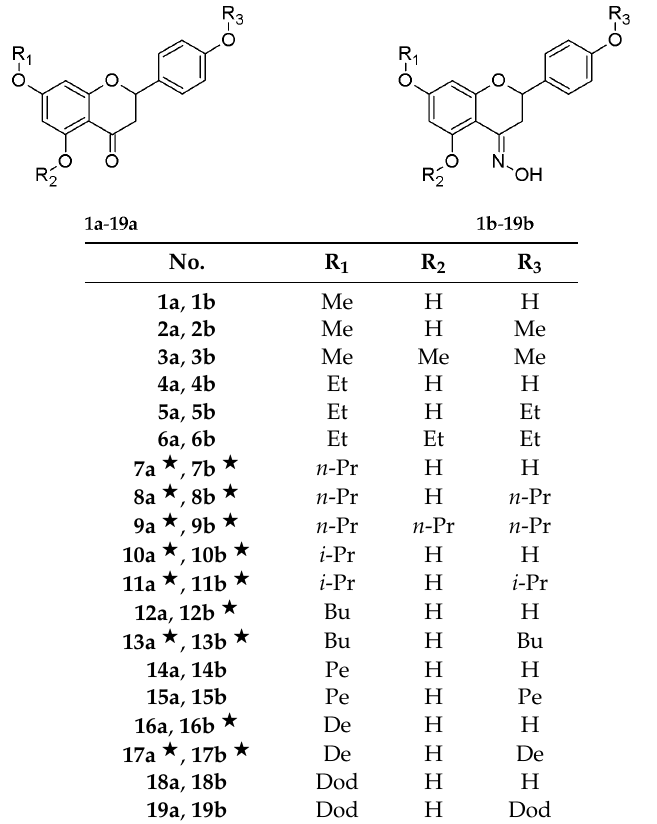
Table 1. Structures of O -alkyl derivatives of naringenin and their oximes.